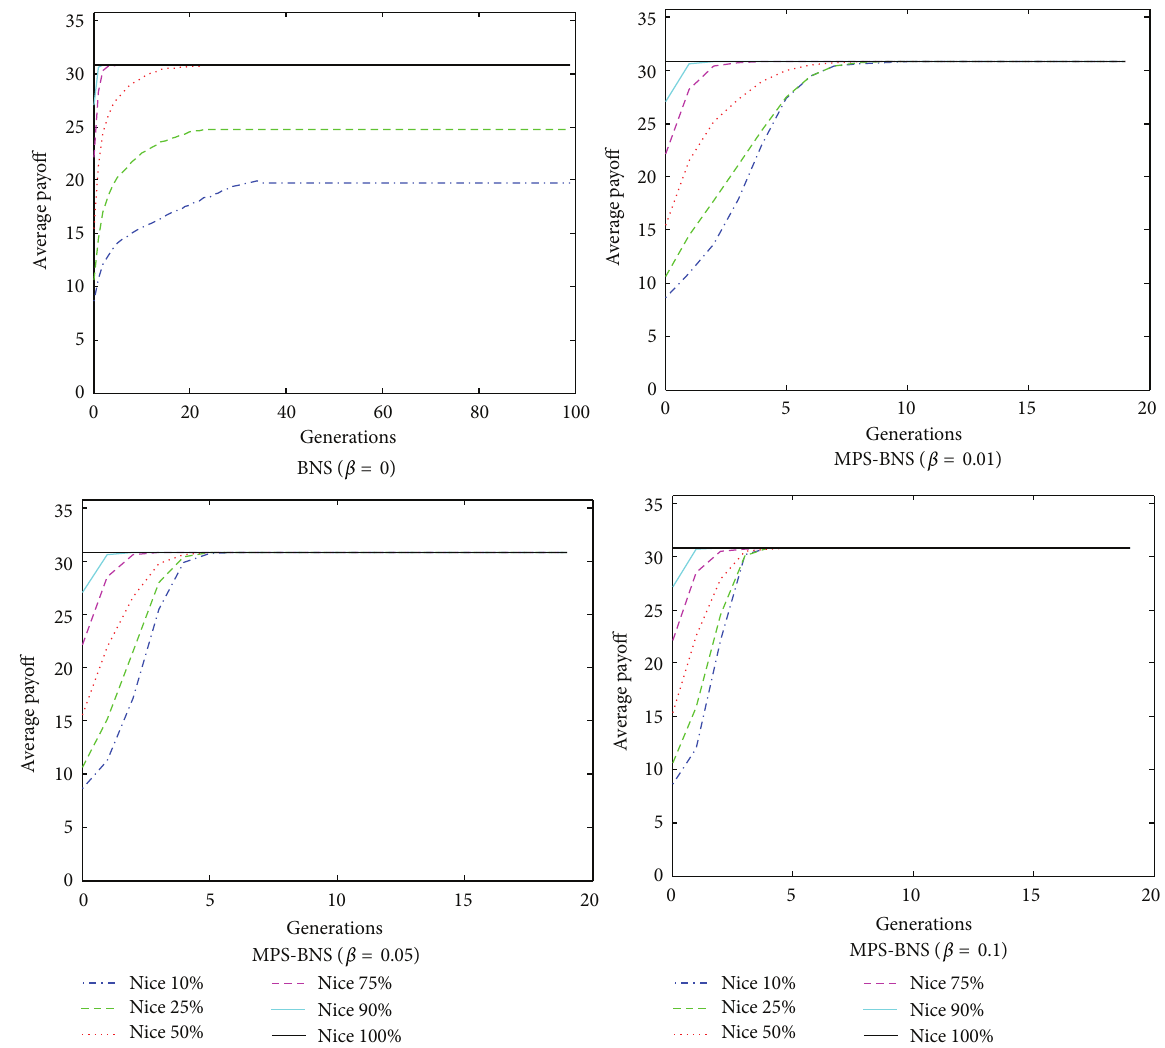
S 6: e average payoff of evolution of MPS-BNS with mixed strategy pro�le.